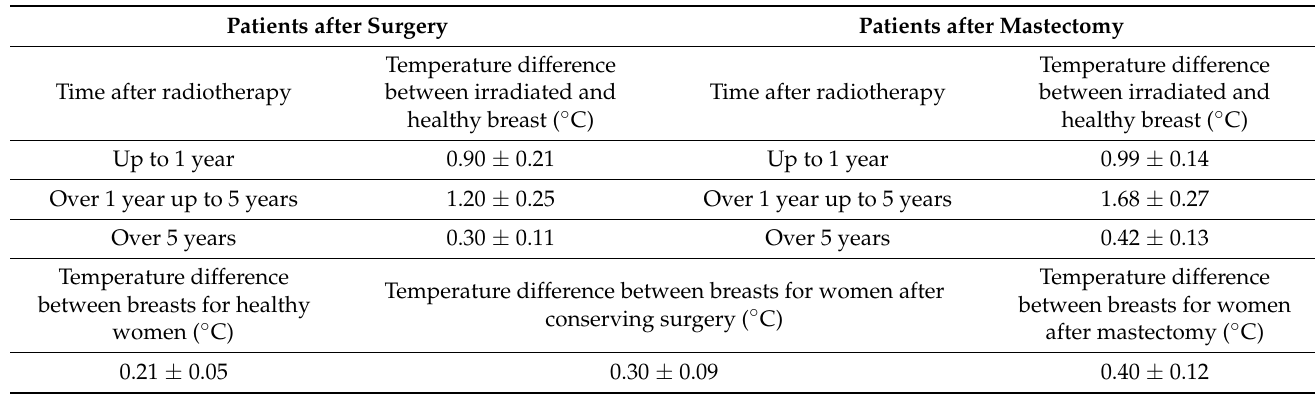
Table 2. The average temperature difference between the irradiated area and a healthy breast depending on the irradiation